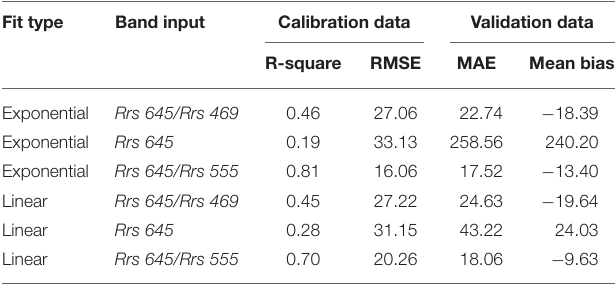
TABLE 1 | Model fit statistics for calibration dataset and validation dataset error metrics for linear and exponential models for estimating TSS from Rrs and Rrs band ratios.